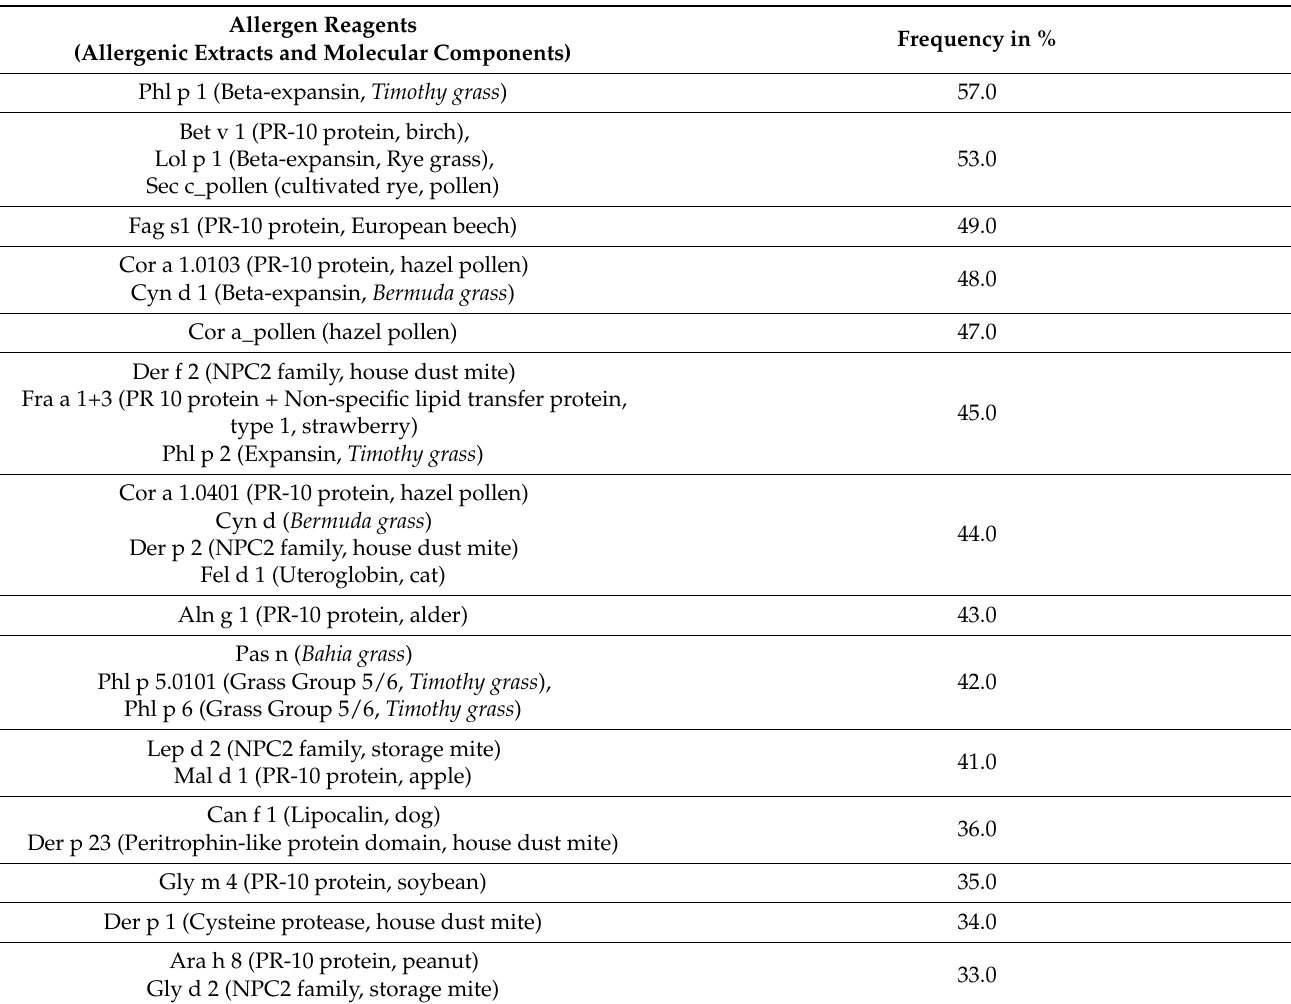
Table 2. The order of allergen reagents (allergenic extracts and molecular components) according to the frequency in 100 atopic dermatitis patients (it is shown the sensitization in the frequency 10% and more). The sensitization to molecular components of molds and yeast (Mala s 5, Mala s 6, Mala s 11, Sac c, Alt a 1, Alt a 6, Asp f 1, Asp f 3, Asp f 4, Asp f 6, Cla h 8 and Pen ch) is recorded extra bold *. Low sensitization rate was observed to Asp f 1, Asp f 4 and to Pen ch ( Penicillium chrysogenum ) in 3–4% of